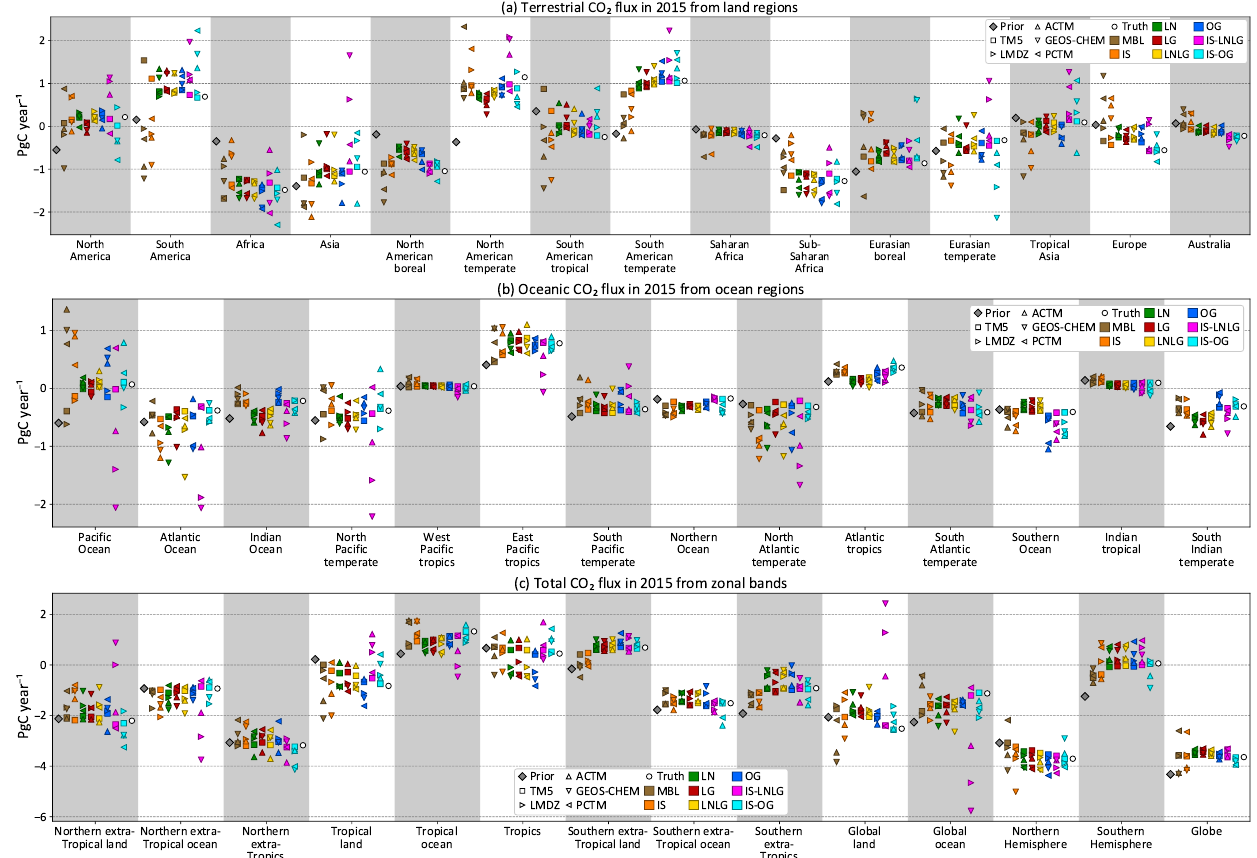
Figure D1. Annual flux estimates from land (a) and ocean regions (b) , and zonal bands (c) . The different colors correspond to different synthetic data streams assimilated: IS stands for in situ, LN stands for land nadir, LG stands for land glint, OG stands for ocean glint and LNLG is LN + LG. The IS-LNLG and IS-OG are hypothetical PBL networks described in Sect. 2.3.3. For each color, the different symbols denote the forward model used to produce the pseudo-data that were assimilated by TM5